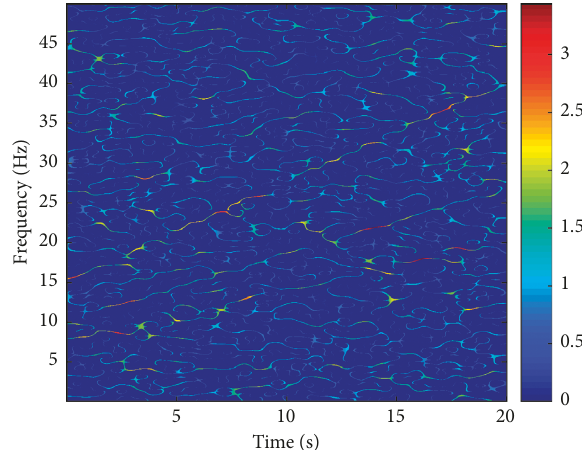
Figure 6: Time-frequency representation of LFM signal based on